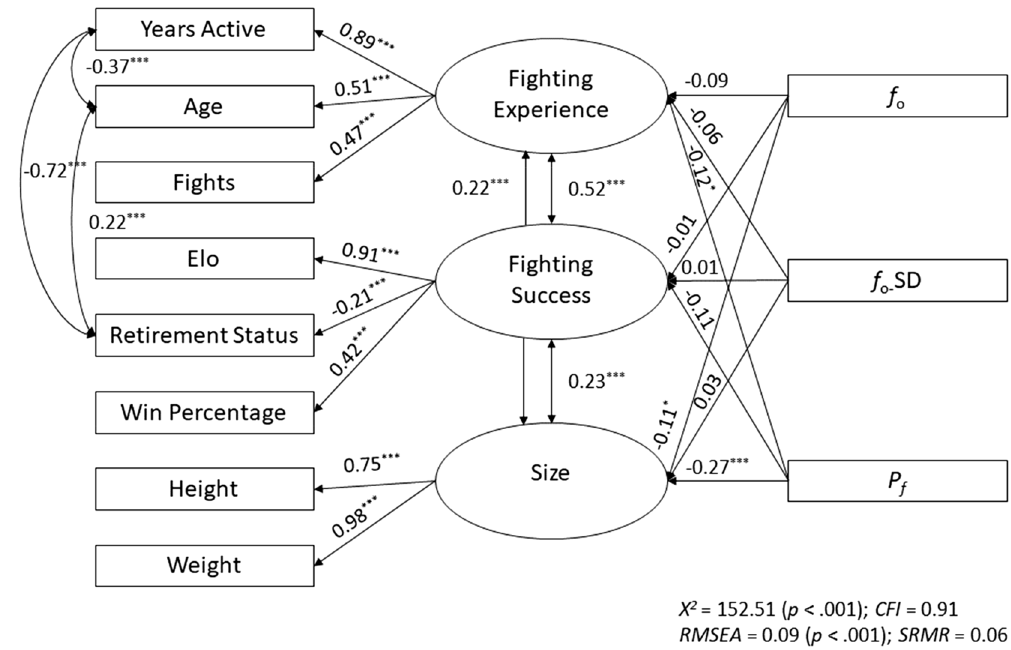
Figure 1. Path diagram for a structural equation model highlighting standardized associations among all observed (rectangular) and latent (oval) variables. We first fitted an orthogonal model, but allowing residual correlations between latent variables significantly improved the model ( p < .001). Note. f o = fundamental frequency; f o -SD = Variability in fundamental frequency; P f = formant position; X 2 = model chi square; CFI = comparative fit index; RMSEA = root mean square error of approximation; SRMR = standardized root mean square residual. p < .05 * , p < .01 ** , p < .001 ***